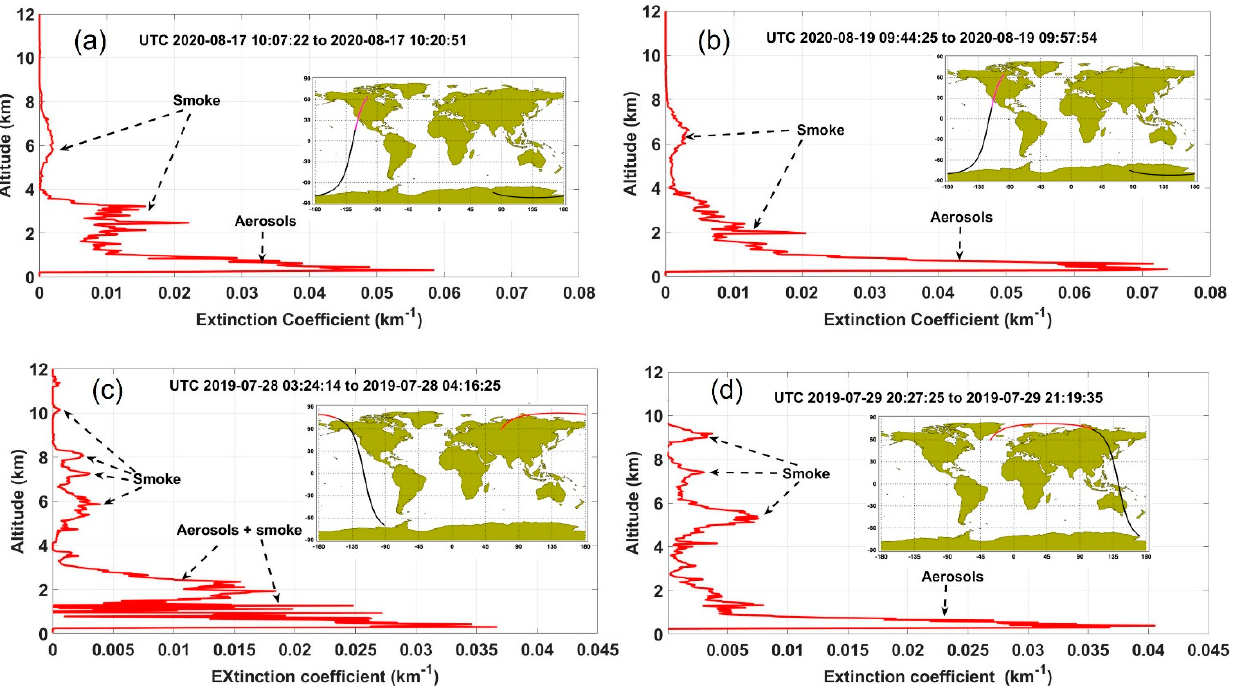
Figure 4. CALIOP vertical height profile of aerosols extinction coefficient over California for the period of ( a ) 17 August 2020 and ( b ) 19 August 2020. CALIOP vertical height profile of aerosols extinction coefficient over Krasnoyarsk Krai for the period of ( c ) 28 July 2019 and ( d ) 29 July 2019.